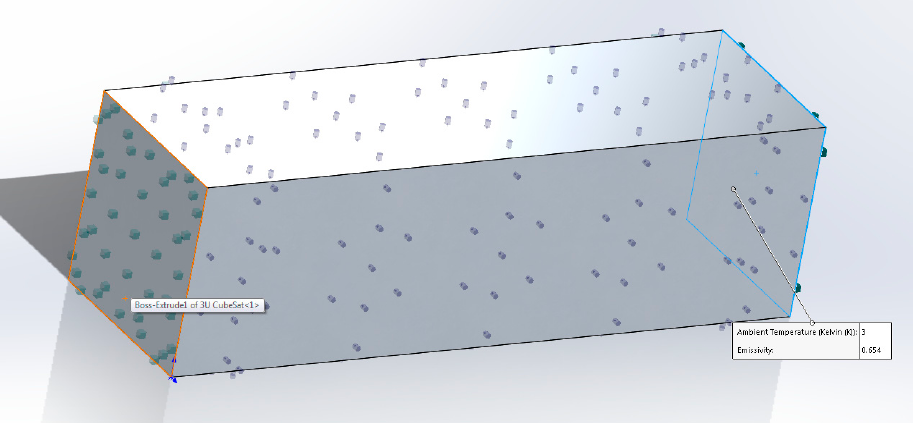
Figure 53. Heat Dissipation to Background Space using Surface to Surface Modelling.